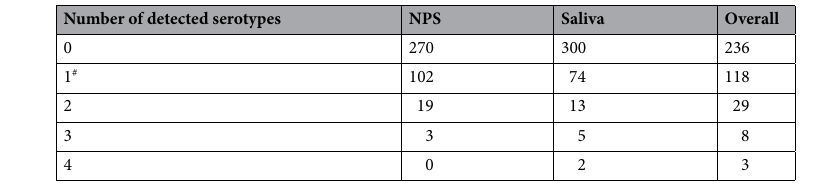
Table 4. Number of serotypes/serogroups detected with any method. # Includes samples pneumococcus- positive for S. pneumoniae in qPCR with no signal for any